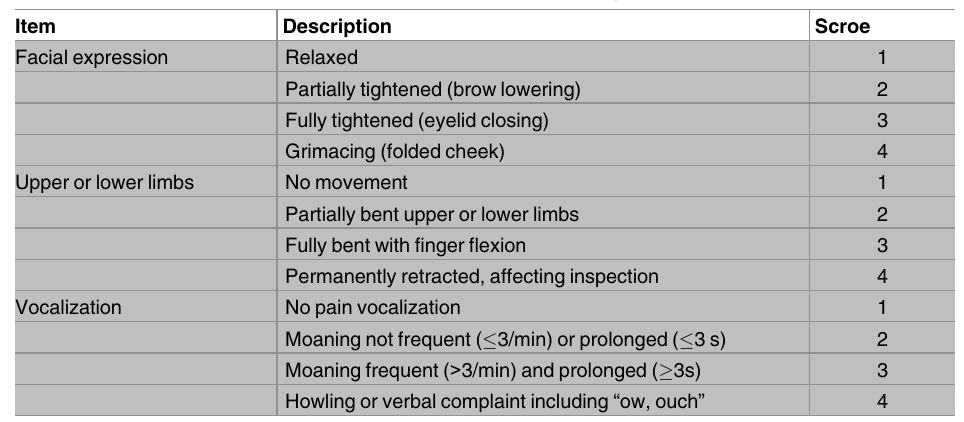
Table 1. Modified Behavioral Pain Scale score for non-intubated patients